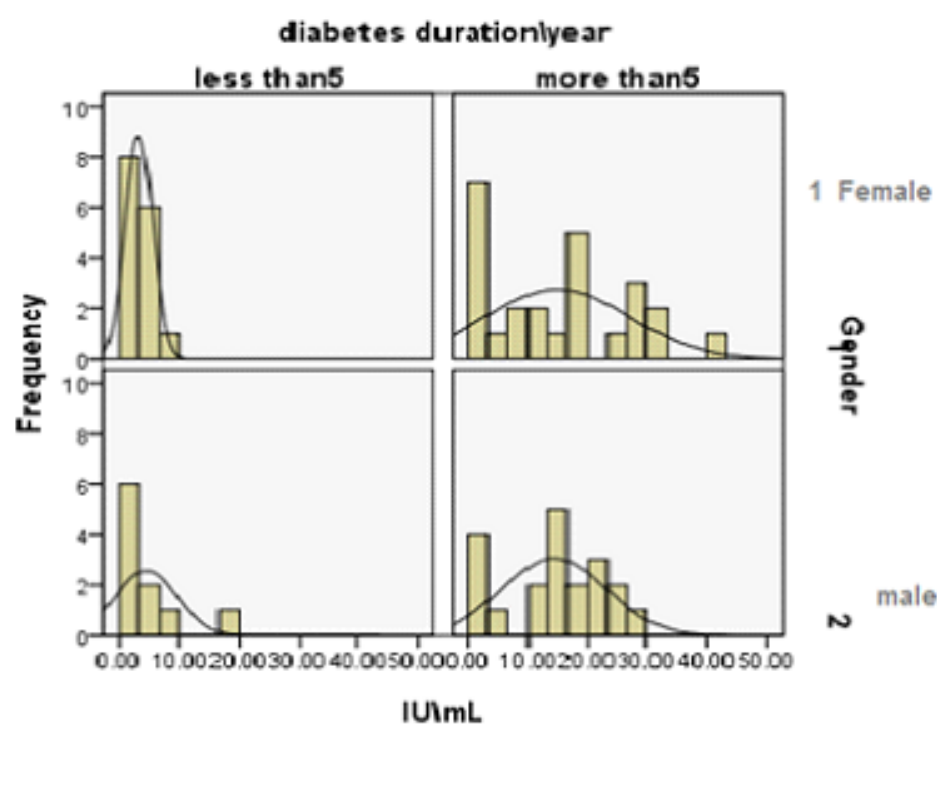
Figure 2: Histogram shows long–stand diabetes patients AMI levels frequency accordance to gender. (1 represent female, 2 represent